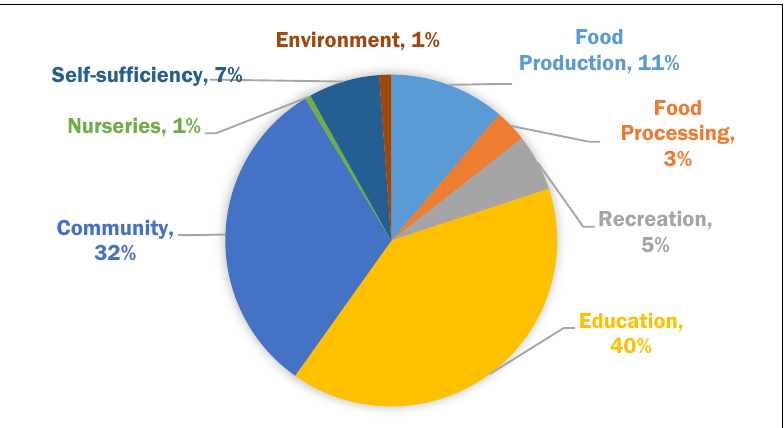
Figure 4. Main Services of Food Forests ( n